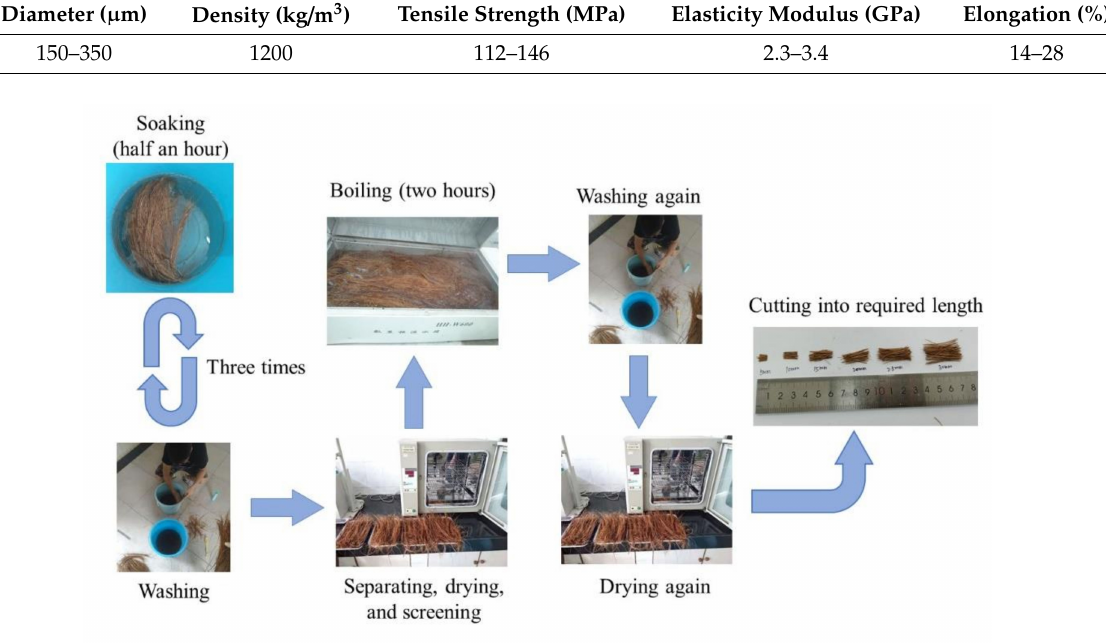
Figure 1. Coir fiber (CF) treating